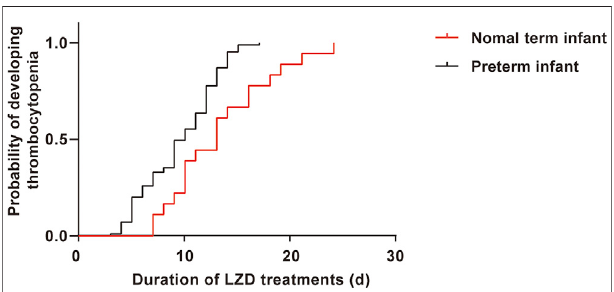
FIGURE 2 | The Kaplan – Meier plot showing the time from initiation of LZD therapytodevelopmentofthrombocytopenia inpreterm infantsandterm infants. The time was much shorter in preterm, had signi fi cant differences when compared with term infants [10 (6, 12) vs . 13 (9.75, 16.5), p =